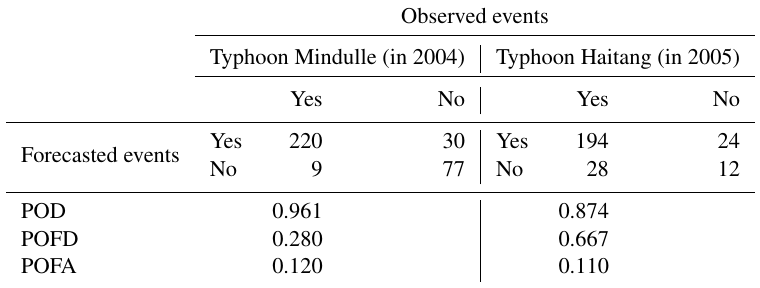
Figure 7. Disastrous landslide cases in 2016, their rainfall histograms, and their rainfall paths in the I 3 – R 24 diagram. The results showed that orange or red alerts could have been issued in advance for these disastrous landslides. Table 11. Validation of alerts issued for villages during Typhoons Mindulle and Haitang by using contingency matrix and skill